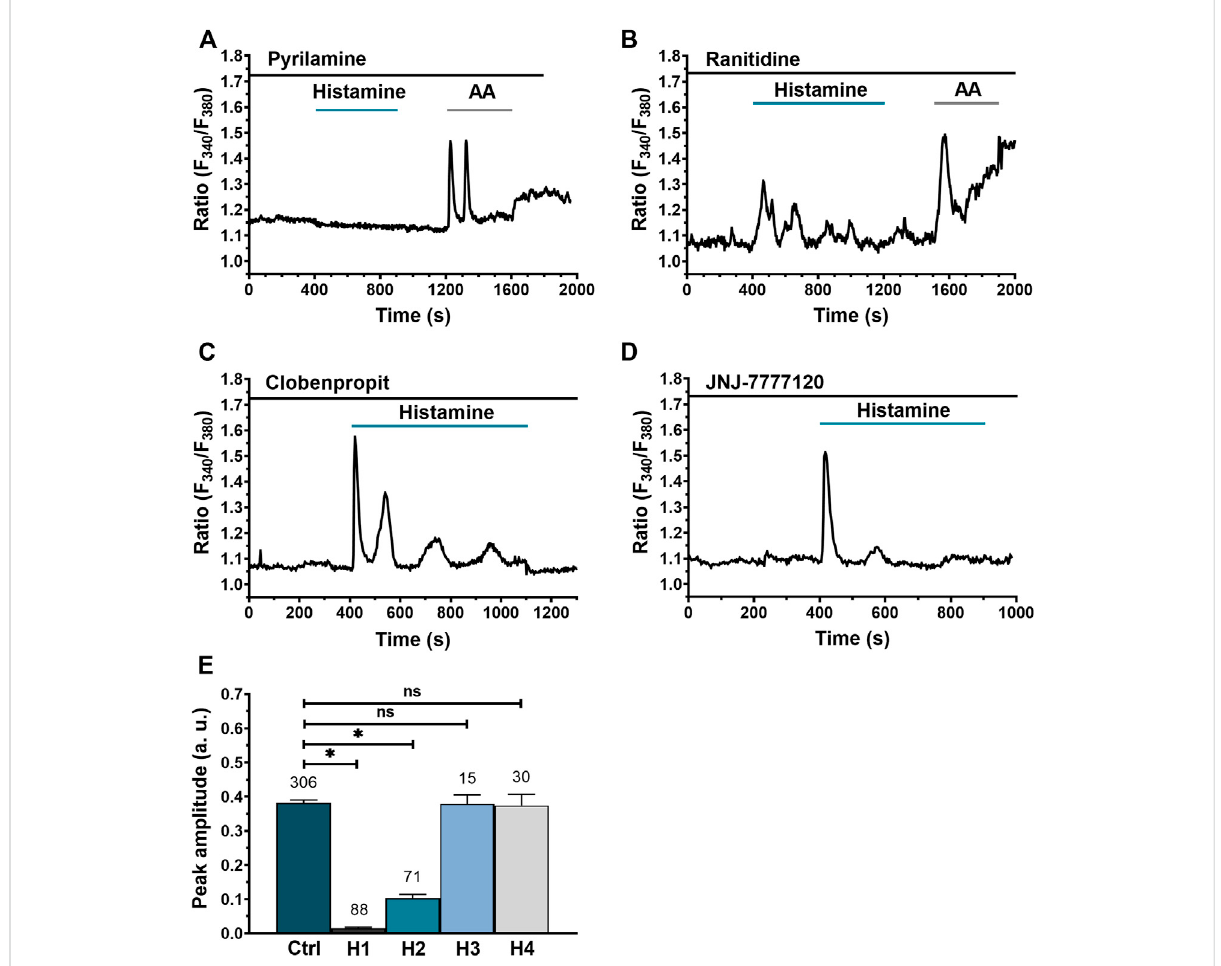
FIGURE 4 Dissection of histaminergic receptors (HR) responsiblefor histamine-evoked Ca 2+ signal inWI-38 human lung fi broblasts. (A) Typical recording of histamine-evoked Ca 2+ signal in the presence of the H1R antagonist, pyrilamine (100 μ M). (B) Typical recording of the histamine-evoked Ca 2+ signalinthepresenceoftheH2Rantagonist,ranitidine(50 μ M). (C) Typicalrecordingofthehistamine-evokedCa 2+ signalinthepresenceoftheH3R antagonist, clobenpropit (50 μ M). (D) Typical recording of histamine-evoked Ca 2+ signal in the presence of H4R antagonist, JNJ-7777120 (10 μ M). All histaminergic antagonists were preincubated for 30 min prior to histamine application (incubation time not shown). For experiments showedin (A,C) ,arachidonicacid(AA50 μ M)wasappliedafterhistamineapplicationtocorroboratecellviability. (E) Mean±SEofthepeakamplitude of the Ca 2+ transient evoked by histamine (300 μ M) in the absence (Ctrl) and presence of the HR antagonists: pyrilamine 100 μ M (H1),